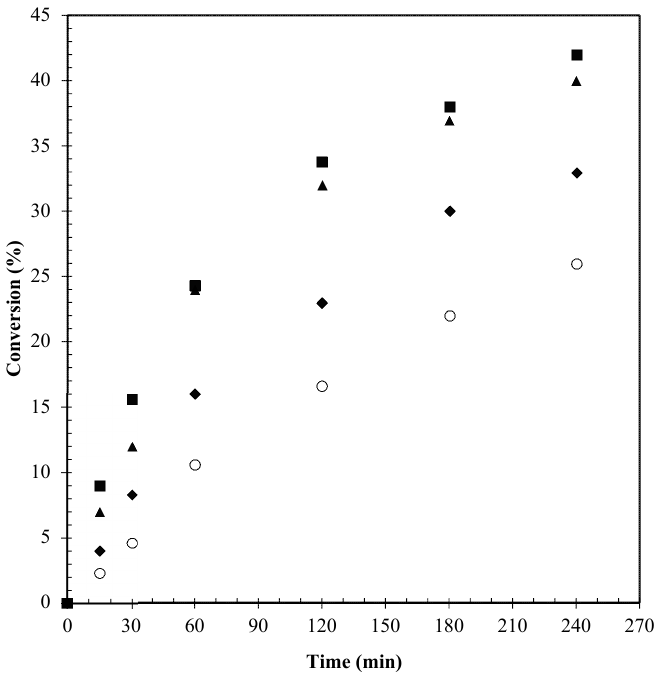
Figure 9. Effect of temperature. Speed of agitation: 1000 rpm, Mole ratio Glycerol:BA = 1:3, catalyst loading 0.03 g/cm 3 , reaction time 4 h. ( ) 130 ◦ C; ( (cid:7) ) 140 ◦ C; ( (cid:78) ) 150 ◦ C; ( (cid:4) ) 160 ◦ C. (cid:35)